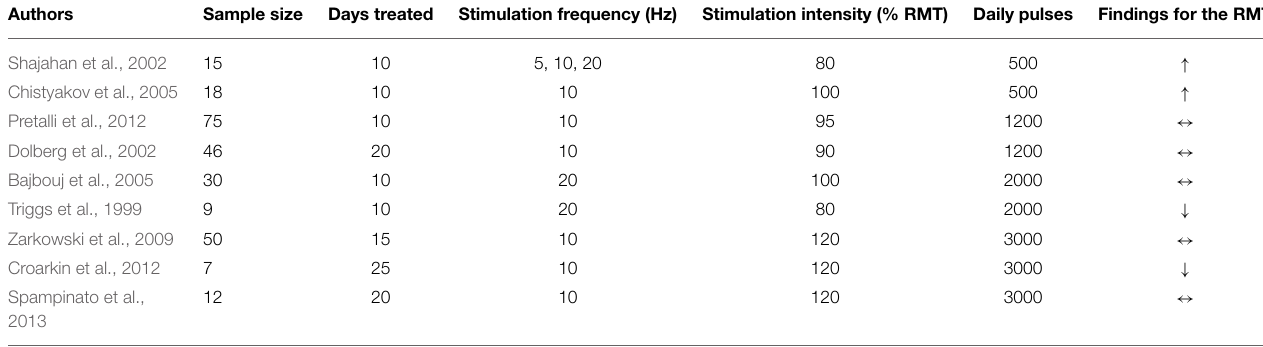
TABLE 4 | Combinations of studies with similar study